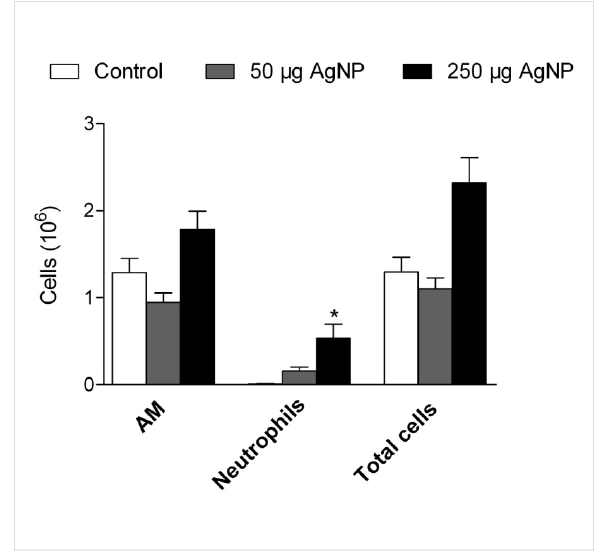
Figure 7: Cell counts in BALF 24 hours after the instillation of PVP- AgNP. AM: Alveolar macrophages. Values are mean ± SEM; n = 5 for each treatment group; *p < 0.05 vs